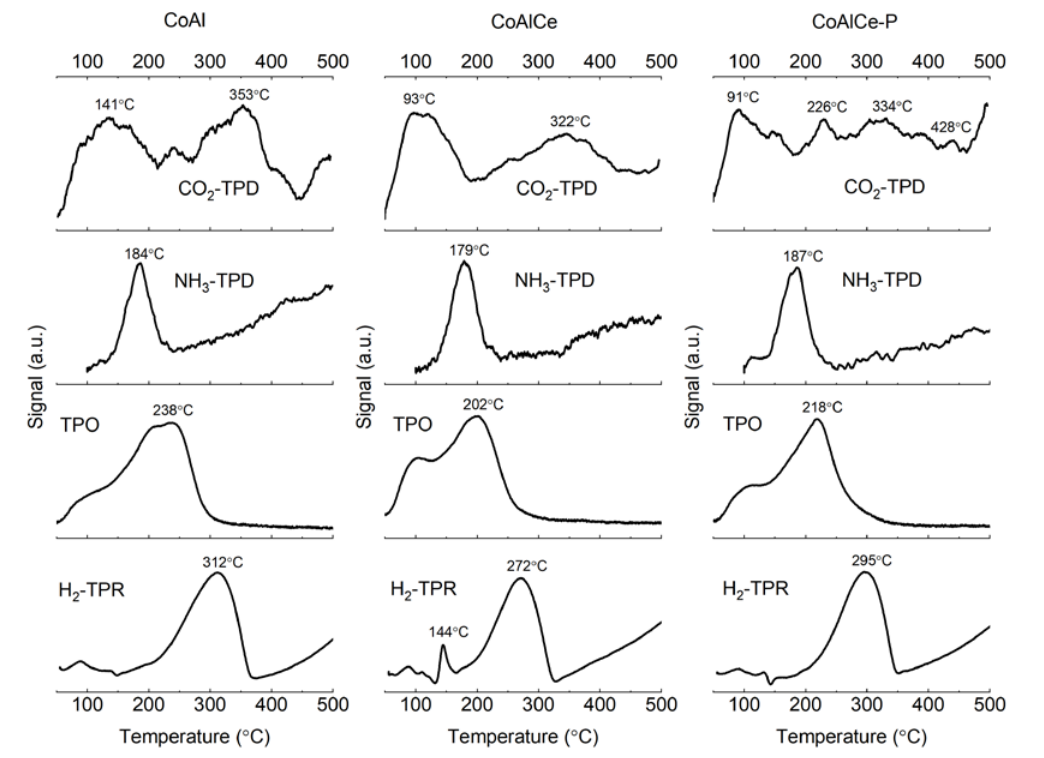
Figure 5. Temperature-programmed reduction, oxidation, NH 3 desorption and CO 2 desorption profiles for the CoAl, CoAlCe and CoAlCe-P samples.